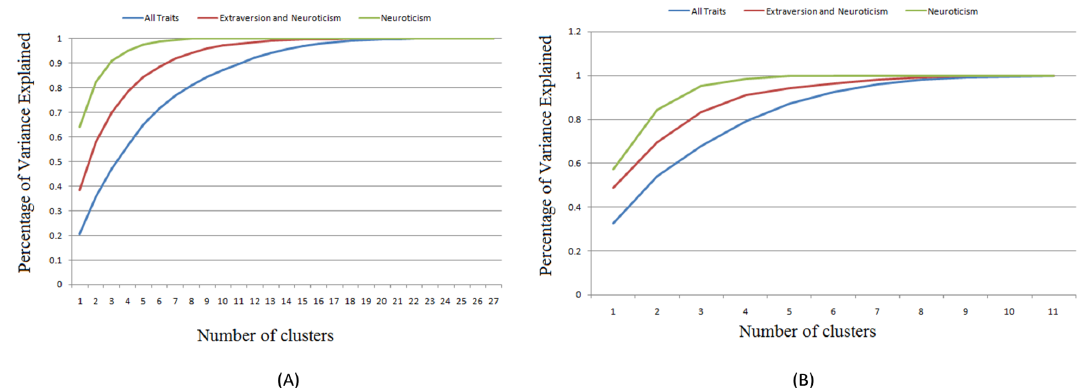
Figure 6. ( A ) Percentage of variance explained in the data based on the number of clusters in the AAL experiments using the personality scores as features, ( B ) Percentage of variance in the dataset explained based on the number of clusters employed for HS experiments using personality scores as